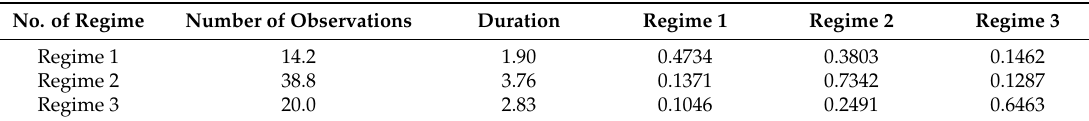
Table 6. Regime transition probability matrices.